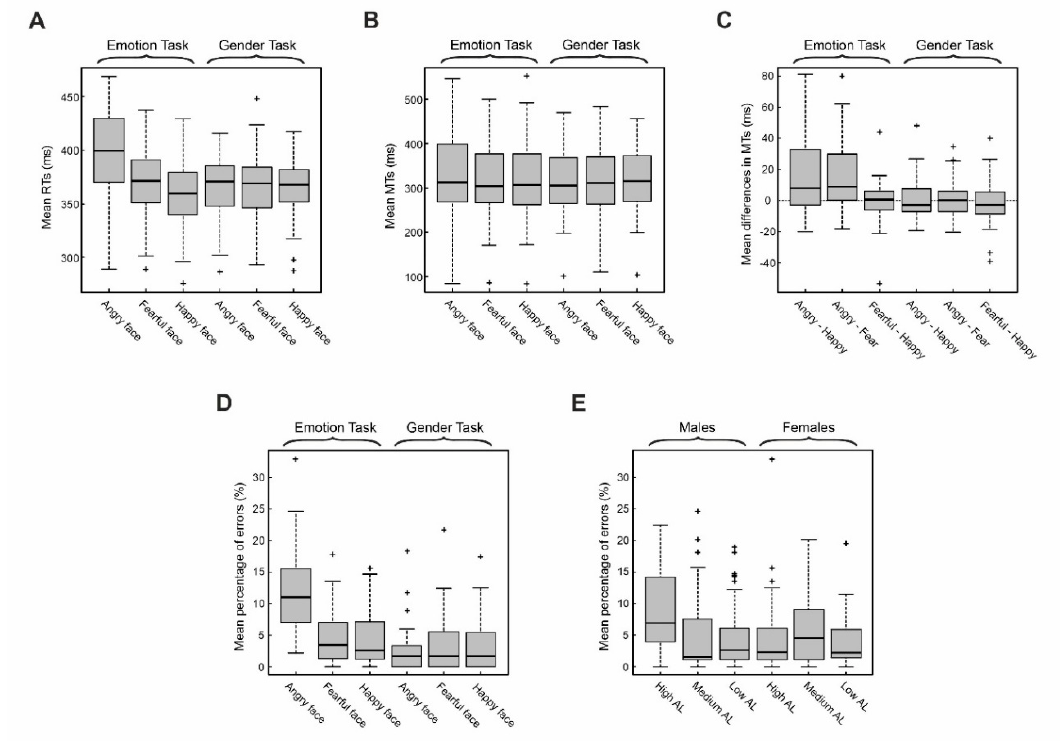
Figure 3. ( A ) E ff ect of emotional facial expressions on reaction times (RTs). Mean RTs for fearful, happy, and angry faces in the Emotion discrimination task (on the left) and Gender discrimination task (on the right). Only in the Emotion discrimination task, participants were slower when the Go-signal was an angry face than when it was a happy or fearful face (Table 2). ( B ) E ff ect of emotional facial expression on movement times (MTs). Average MTs in the Emotion discrimination task are displayed on the left and MTs in the gender recognition task on the right. In the Emotion discrimination task, participants were slower when the Go-signal was an angry face than when it was a happy or fearful face (Table 3). ( C ) Mean of the di ff erences of MTs between each pair of emotional facial expressions in each of the two tasks. ( D ) E ff ect of emotional facial expression on the percentage of errors. Mean percentage of errors to angry, fearful, and happy faces in the Emotion discrimination task (on the left) and Gender discrimination task (on the right). Participants made more mistakes in the Emotion discrimination task than in the Gender discrimination task. In addition, in the Emotion discrimination task, a higher percentage of mistakes occurred when the Go-signal was an angry face than when it was a happy or fearful face (Table 4). ( E ) E ff ect of arousal level (AL) on the percentage of errors. Results were split according to the participants’ gender. Overall, males made fewer mistakes than females. However, males with high AL made more mistakes than in any other condition (Table 4). In each box plot, the boundary of the box closest to zero indicates the first quartile, a black line within the box marks the median, and the boundary of the box farthest from zero indicates the third quartile. Whiskers indicate values 1.5 times the interquartile range below the first quartile and above the third quartile.